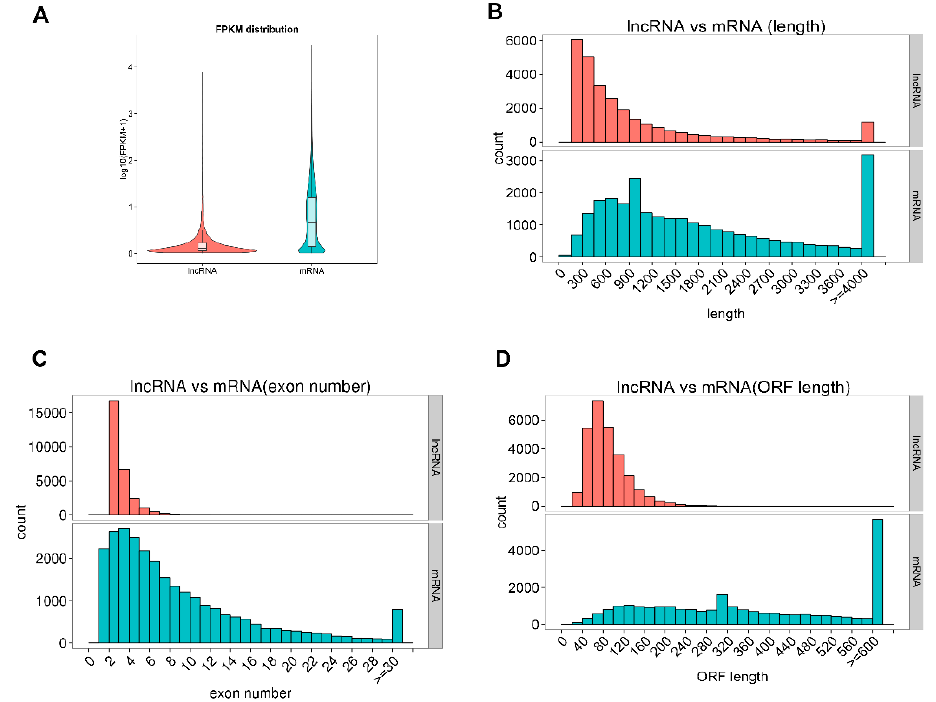
Figure 2. Comparison of expression levels and genomic feature of predicted long non-coding RNAs (lncRNAs) and mRNAs in pregnant swine placentas. ( A ) The expression levels (log 10 (FPKM + 1)) of mRNAs and lncRNAs; The ( B ) length, ( C ) exon number, ( D ) Open reading frame (ORF) length of mRNAs and lncRNAs, respectively.